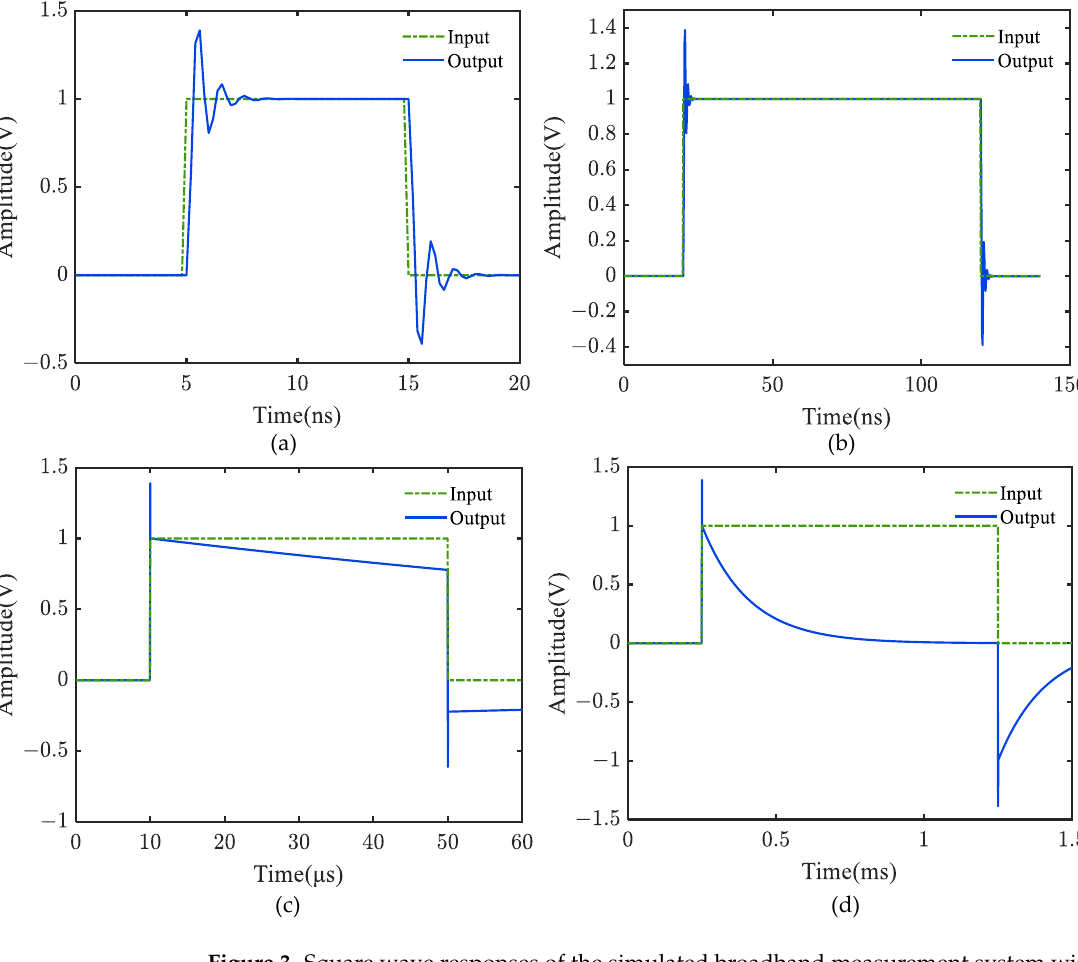
Figure 3. Square wave responses of the simulated broadband measurement system with different pulse widths. ( a ) 10 ns; ( b ) 100 ns; ( c ) 40 µs; ( d ) 1 ms.